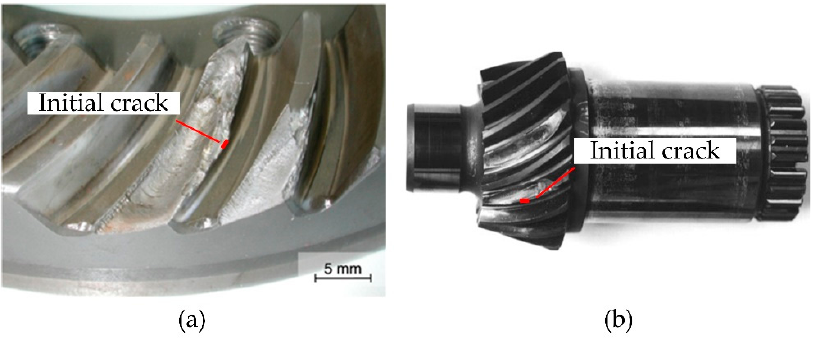
Figure 1. Cross-sectional appearance of broken teeth of bevel gears: ( a ) Gear [7]; ( b ) Pinion [3].